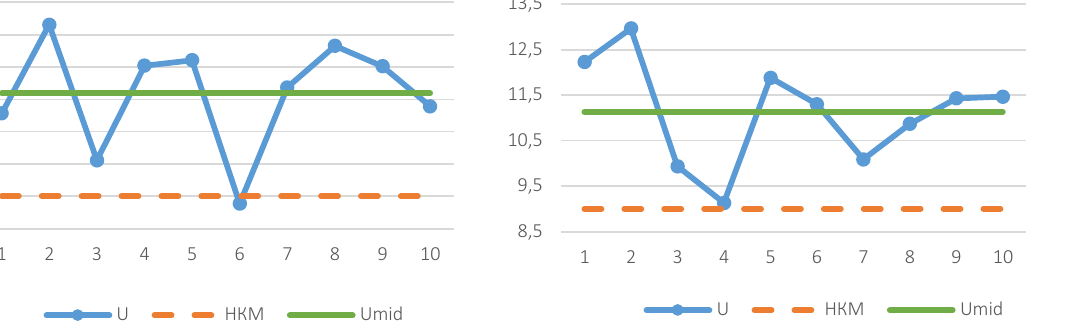
Figure 1. The Shewhart chart for the H2 (regulatory capital adequacy) evolution